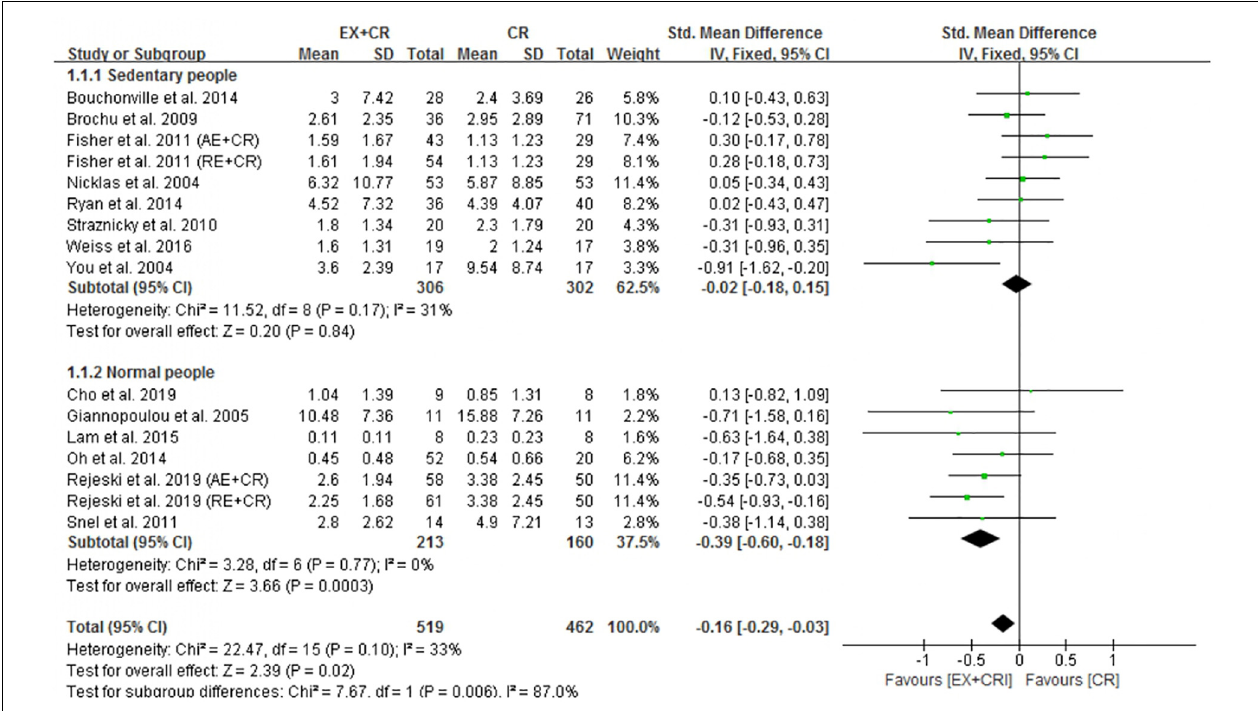
FIGURE 2 | Forest plot of the effects of exercise plus calorie restriction (EX + CR) intervention on C-reactive protein (CRP) changes in overweight and obese adults with different (subgroup analysis) lifestyle behaviors.